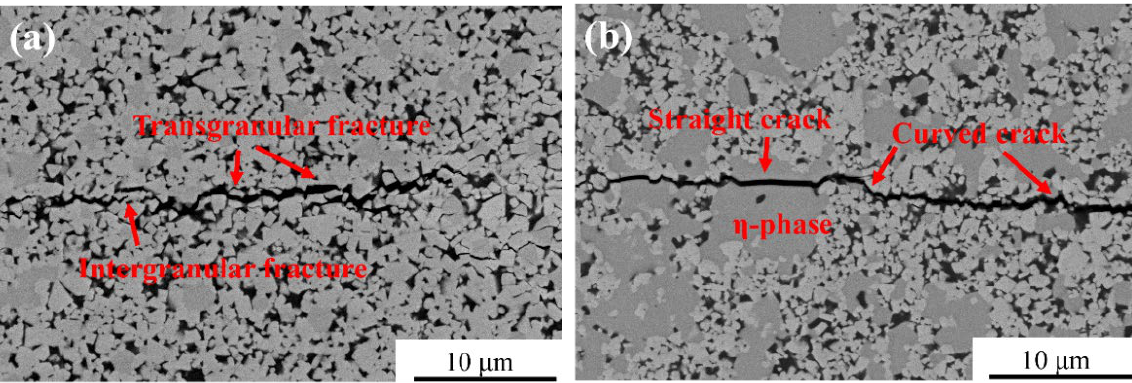
Figure 12. Crack microstructure of ( a ) 0Mo-5.13C, and ( b ) 2.5Mo-5.0C samples.